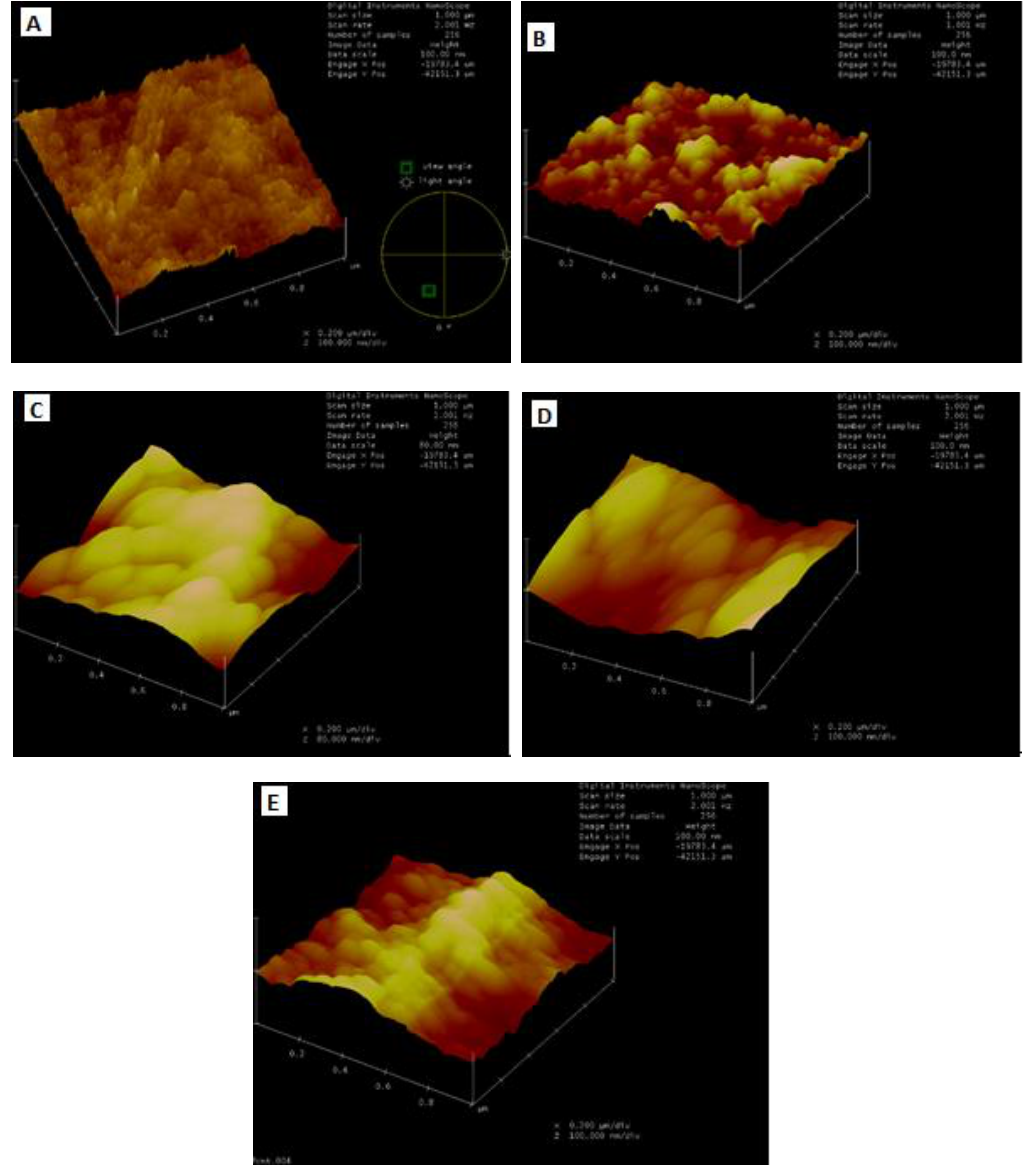
Figure 4. Atomic force microscopy (AFM) 3D surface morphology images of ( A ) 0% CNT, ( B ) 0.5% p-CNT, ( C ) 1% p-CNT, ( D ) 1.5% p-CNT and ( E ) 1% f-CNT .